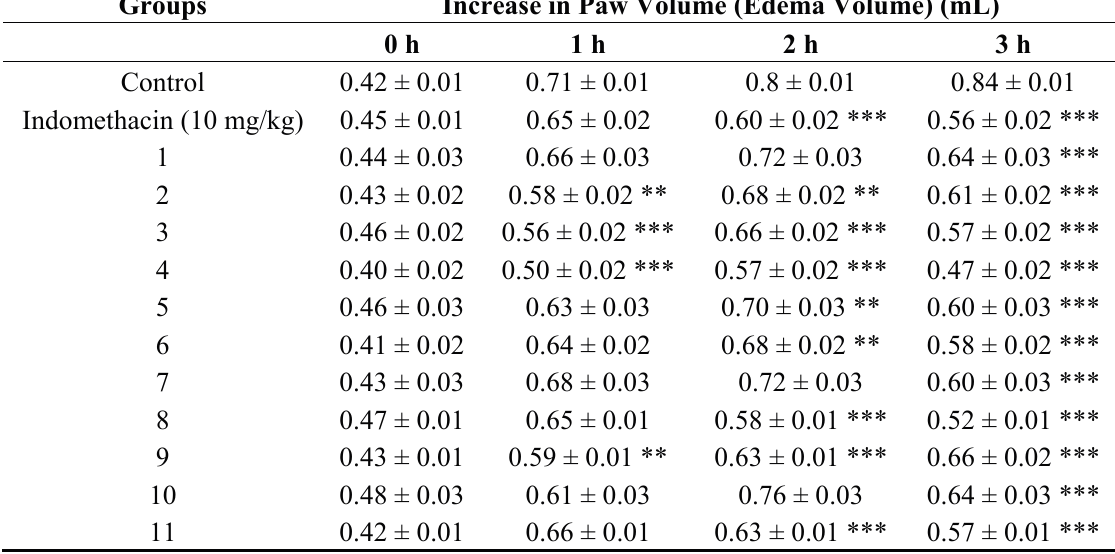
Table 1. The anti-inflammatory activity of the tested compounds and reference drug (Indomethacin) in carrageenan-induced rat paw edema assay, Values are expressed as mean ± SEM, ( n = 8).